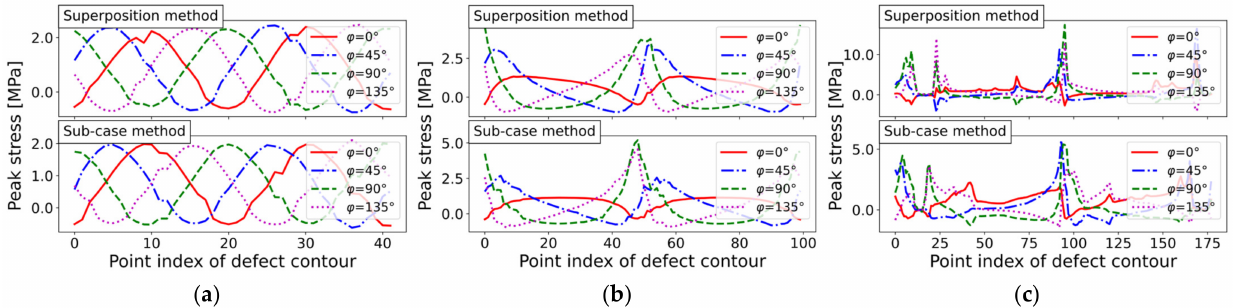
Figure 18. PSM peak stress course for three defect geometries and incremental load step of ∆ ϕ = 10 ◦ : ( a ) Circular hole-in-plate (mesh ‘circle_lin_R1mm_v1’); ( b ) Elliptical hole-in-plate (mesh ‘ellip- sis_lin_rot0deg_v1’); and ( c ) Elongated defect (mesh